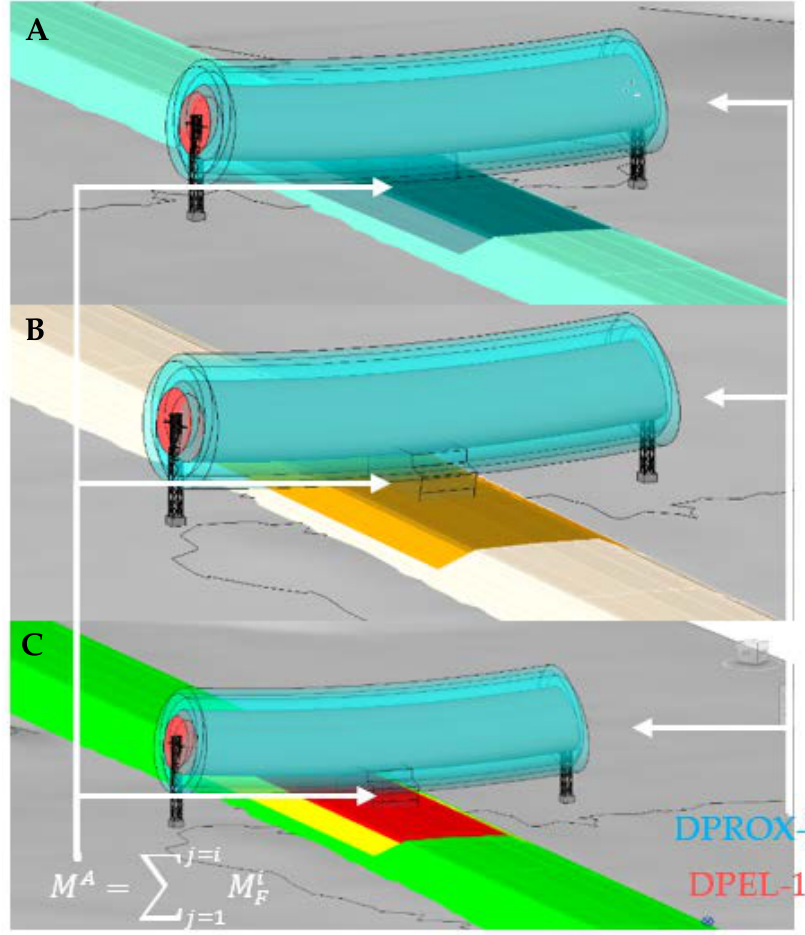
Figure 6. Risk assessment of the study area for the implementation of the embankment and road surface (color coded according to Table 1). ( A ) Risk probability (1 = light blue, 2 = medium blue, 3 = dark). ( B ) Risk severity (1 = light orange, 2 = medium orange, 3 = dark orange). ( C ) Risk assessment (1 = light green, 2 = dark green, 4 = yellow, 6 = orange, 9 = red). Note: Delimitation of the zones according to the diagram in Figures 2 and 3.